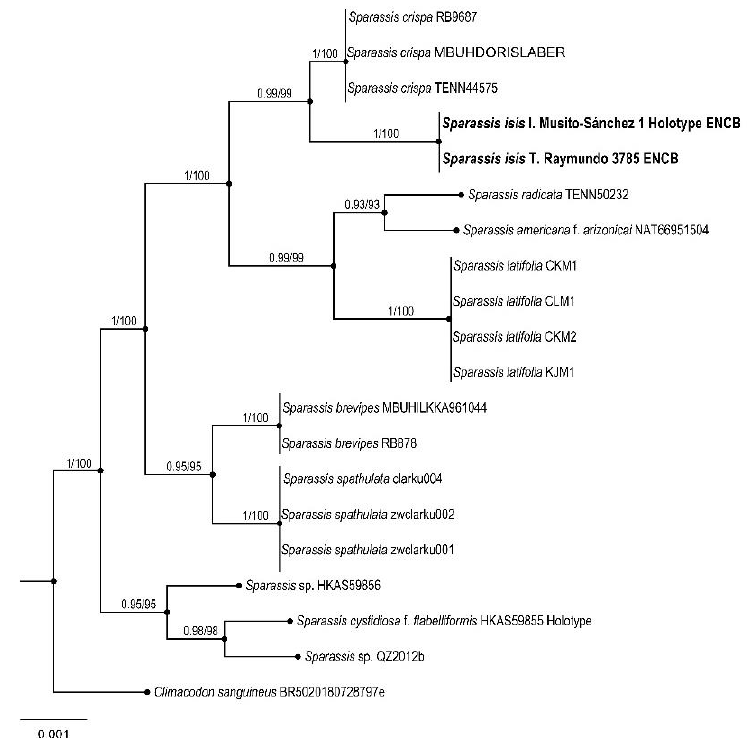
Figure 7. Sparassis isis . ( A – C ): basidiomata; ( D ): optical microscope images of the hymeniiferous trama; ( E ): optical microscope images of hymenium; ( F ): optical microscope images of basidiospores.